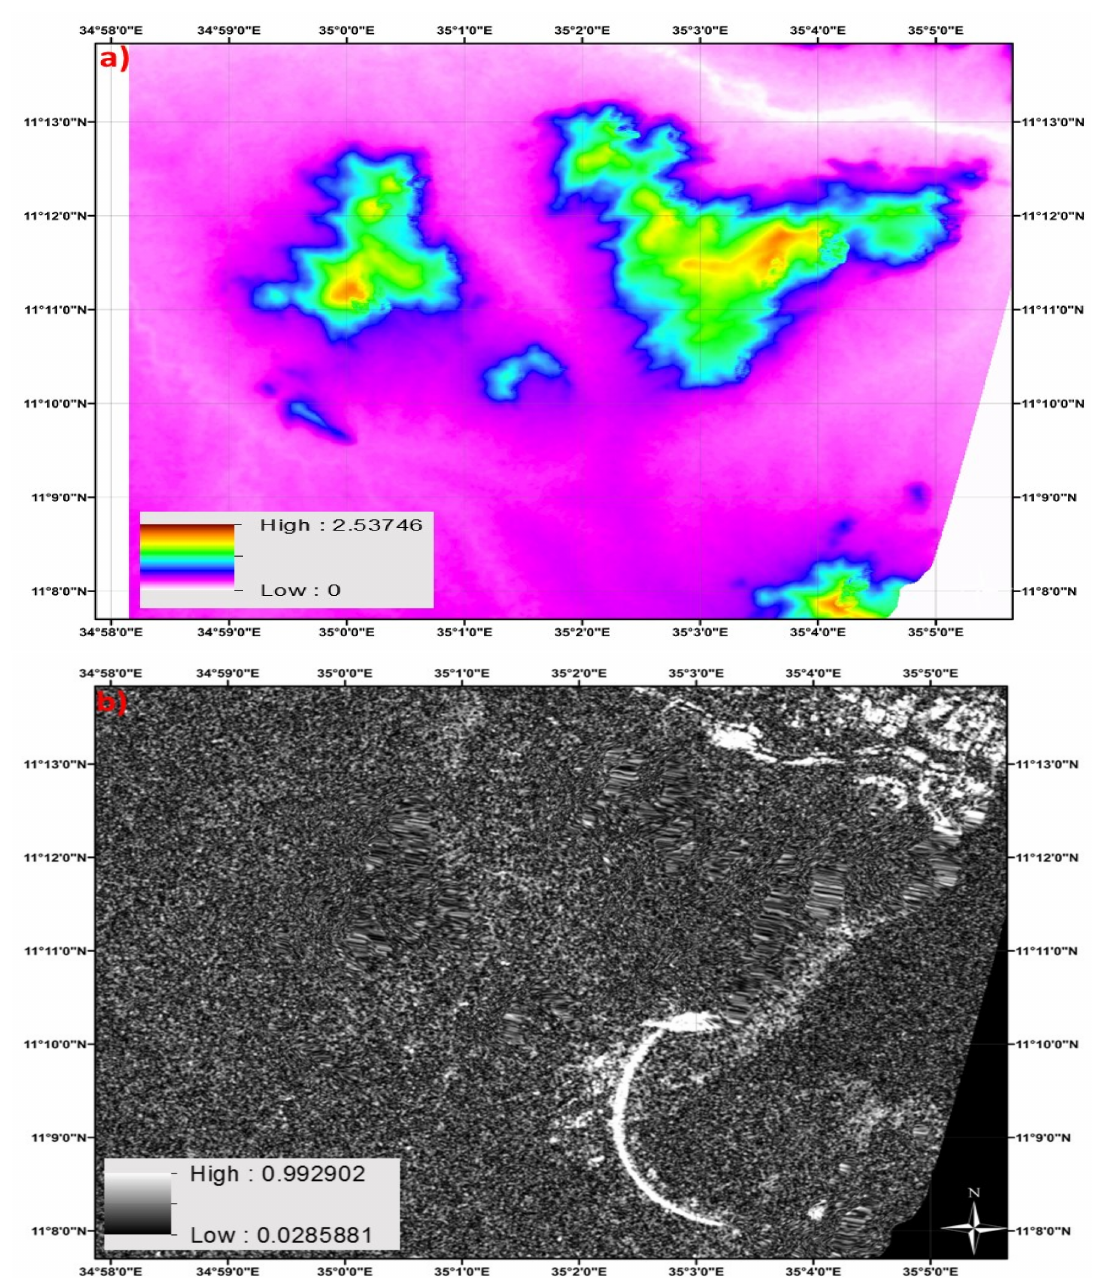
Figure 3. Processing of two Sentinel-1 acquisitions displayed over the GERD location showing ( a ) phase difference and ( b )